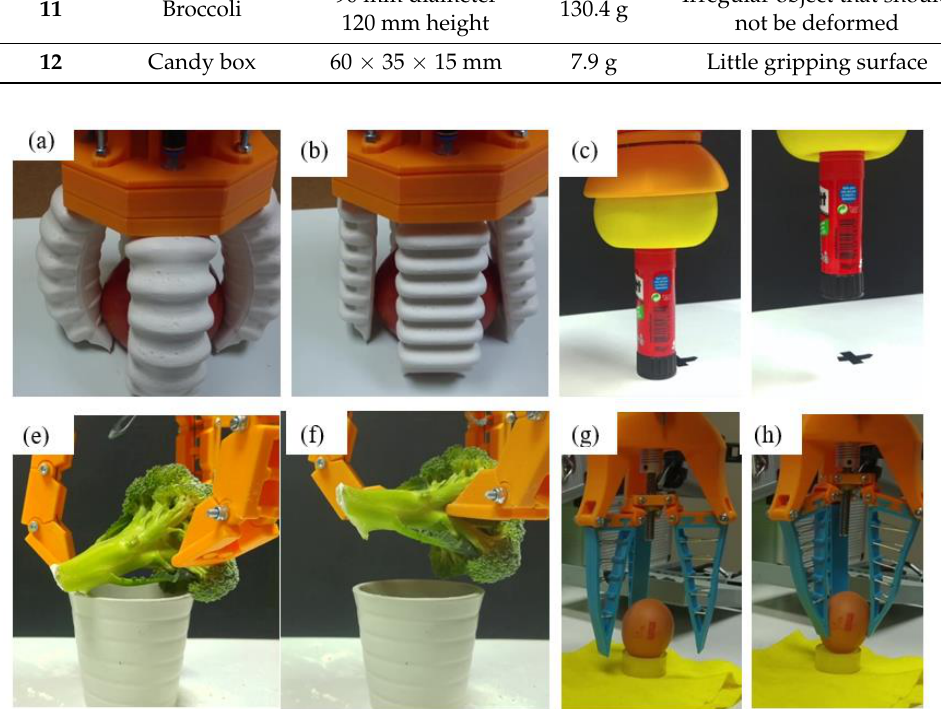
Figure 10. Test execution with Gripper 1 ( a , b ), Gripper 2 ( c , d ), Gripper 3 ( e , f ), Gripper 4 ( g , h ).